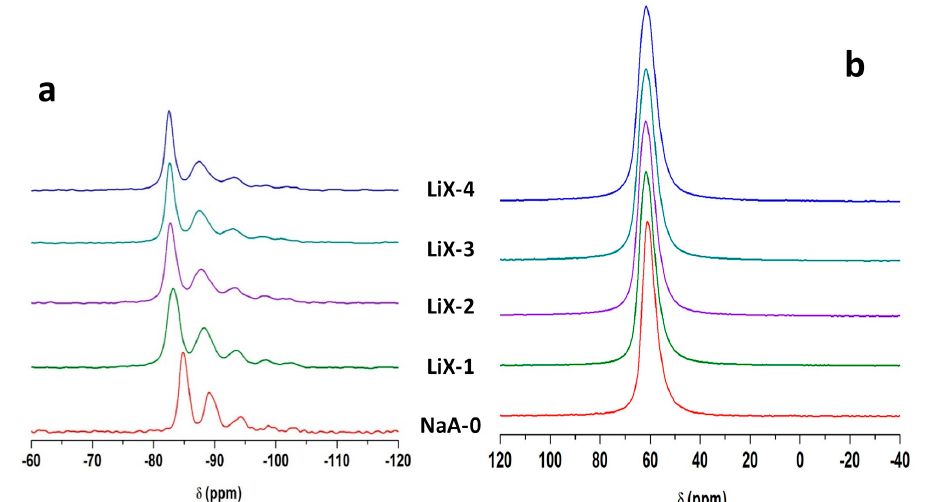
Figure 8. 29 Si-MAS NMR spectra ( a ) and 27 Al-MAS NMR spectra ( b ) of NaX-0 and its associated LiX-1 to LiX-4 samples. Only the isotropic region is shown.